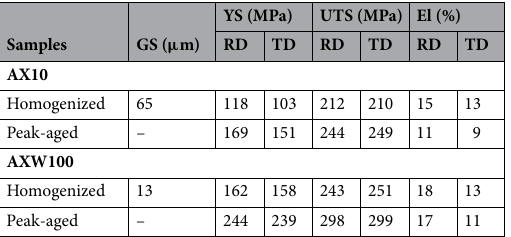
Table 1. Grain sizes (GS) and yield strength (YS), ultimate tensile strength (UTS) and elongation (El) of the homogenized and peak-aged AX10 and AXW100 sheets along the RD and TD.